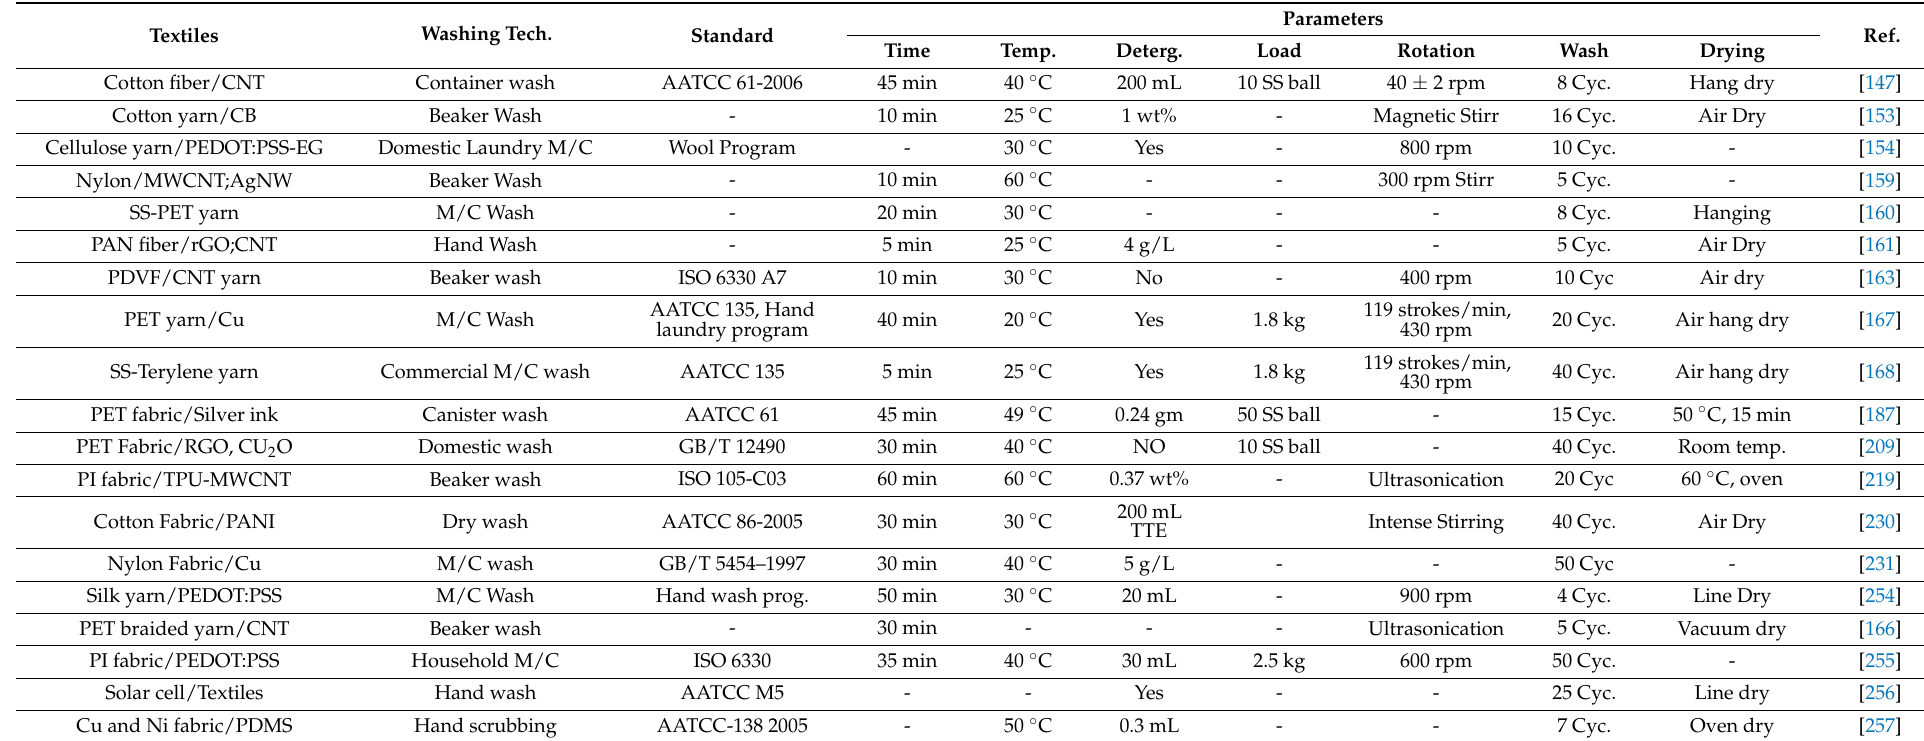
Table 5. Different washing strategies in absence of standardized durability assessment protocols for